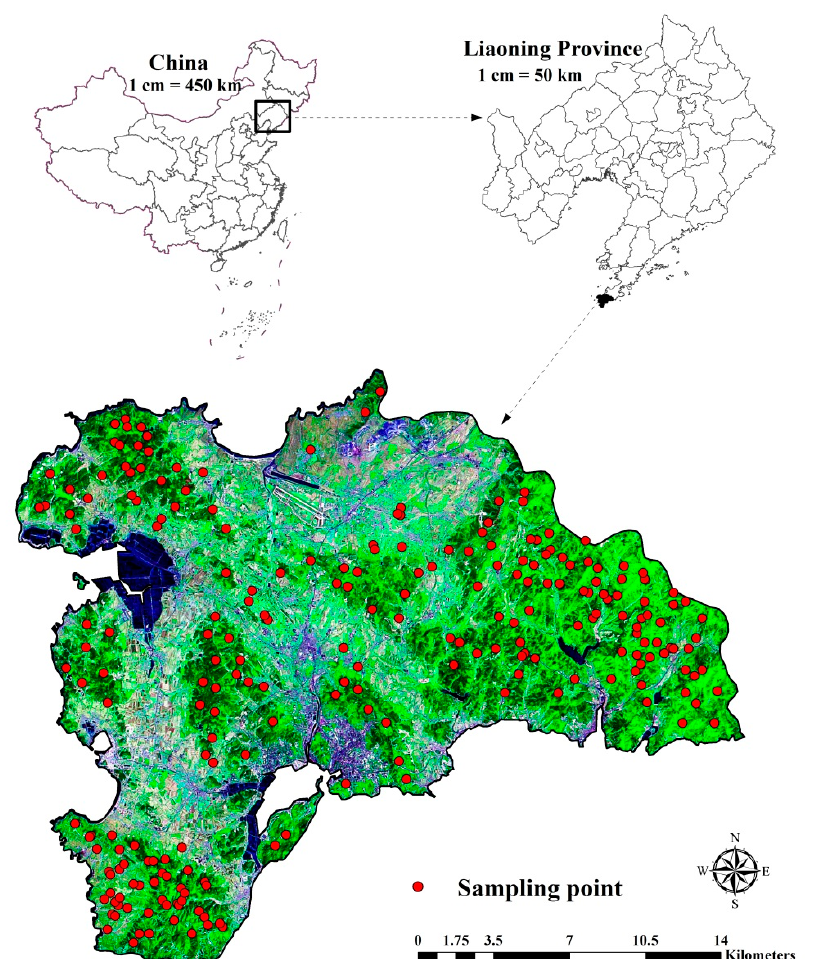
Figure 1. Location of the study area and sampling points, which are superimposed on a 30-m resolution remote sensing image.